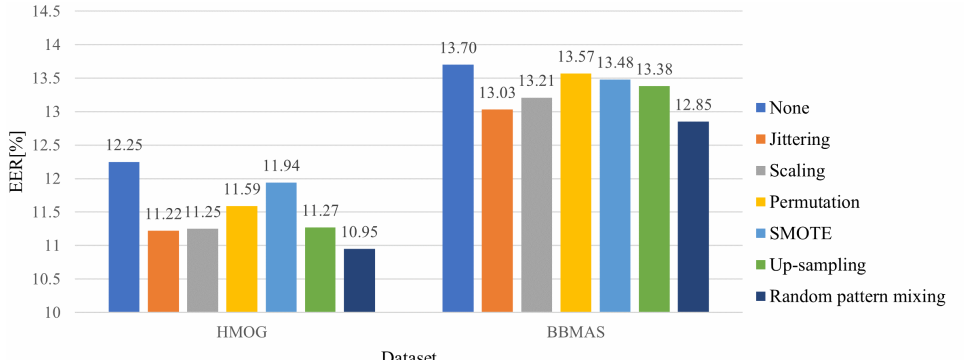
Figure 5. Averaged EERs (%) for different data augmentation